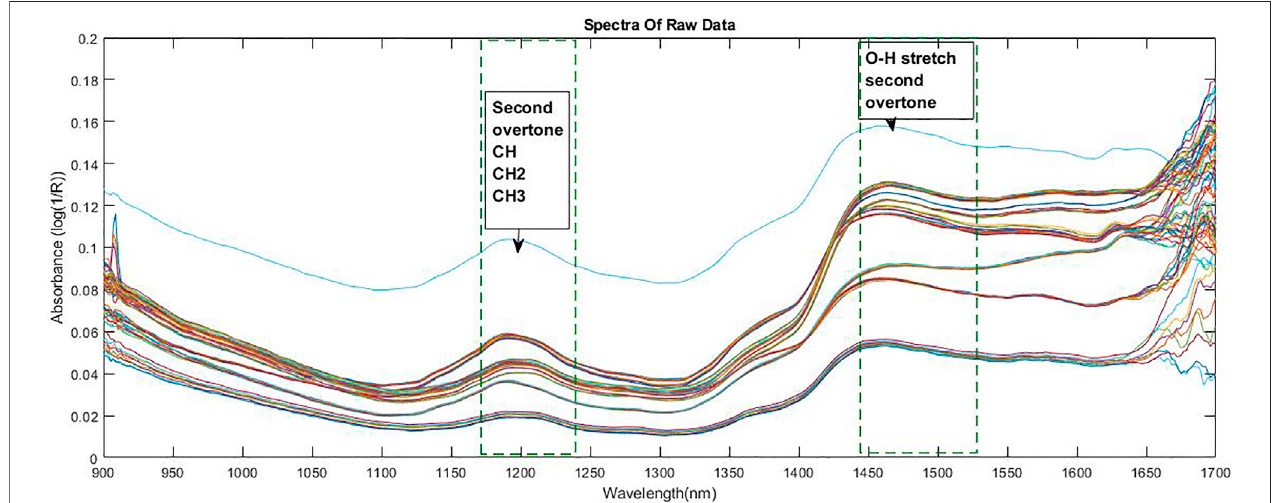
FIGURE 3 | Wavelength vs. absorbance of the original spectra without pre-processing.